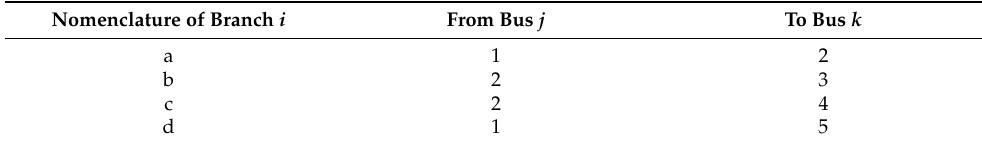
Table 2. Bus connections for the example shown in Figure